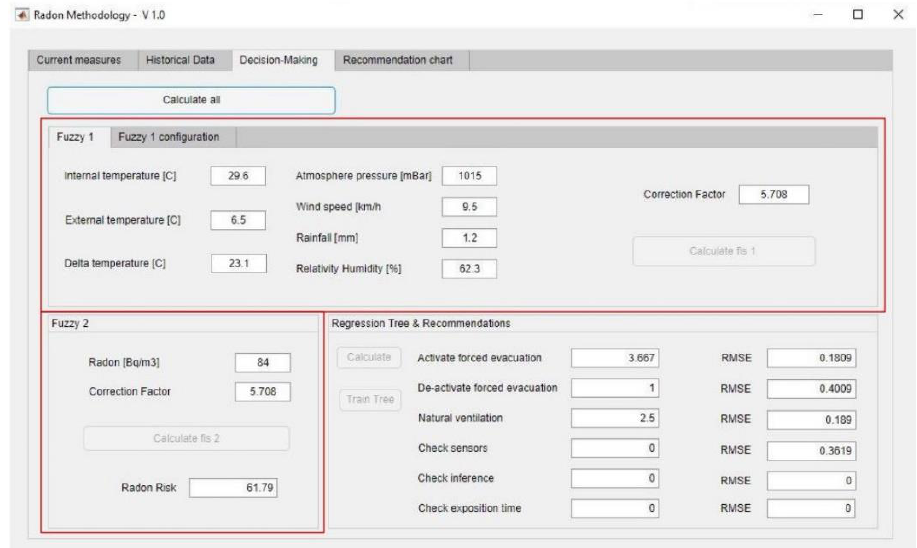
Figure 9. Dashboard for inference systems 1 and 2.